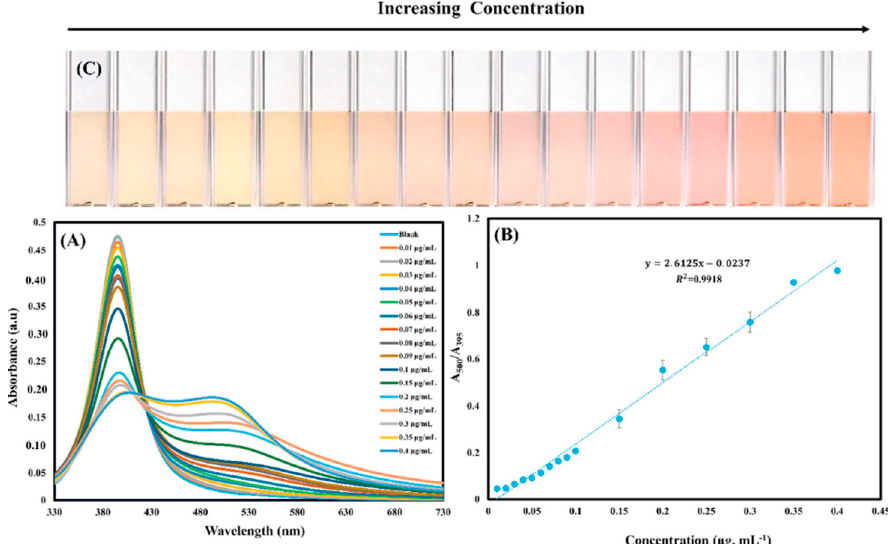
Figure 12. AgNPs UV–vis spectra ( A ) and linear calibration curve ( B ) and color ladder for the colorimetric detection of prothioconazole with the common photograph of AgNPs solution ( C ) in the presence of different concentrations of prothioconazole [154].